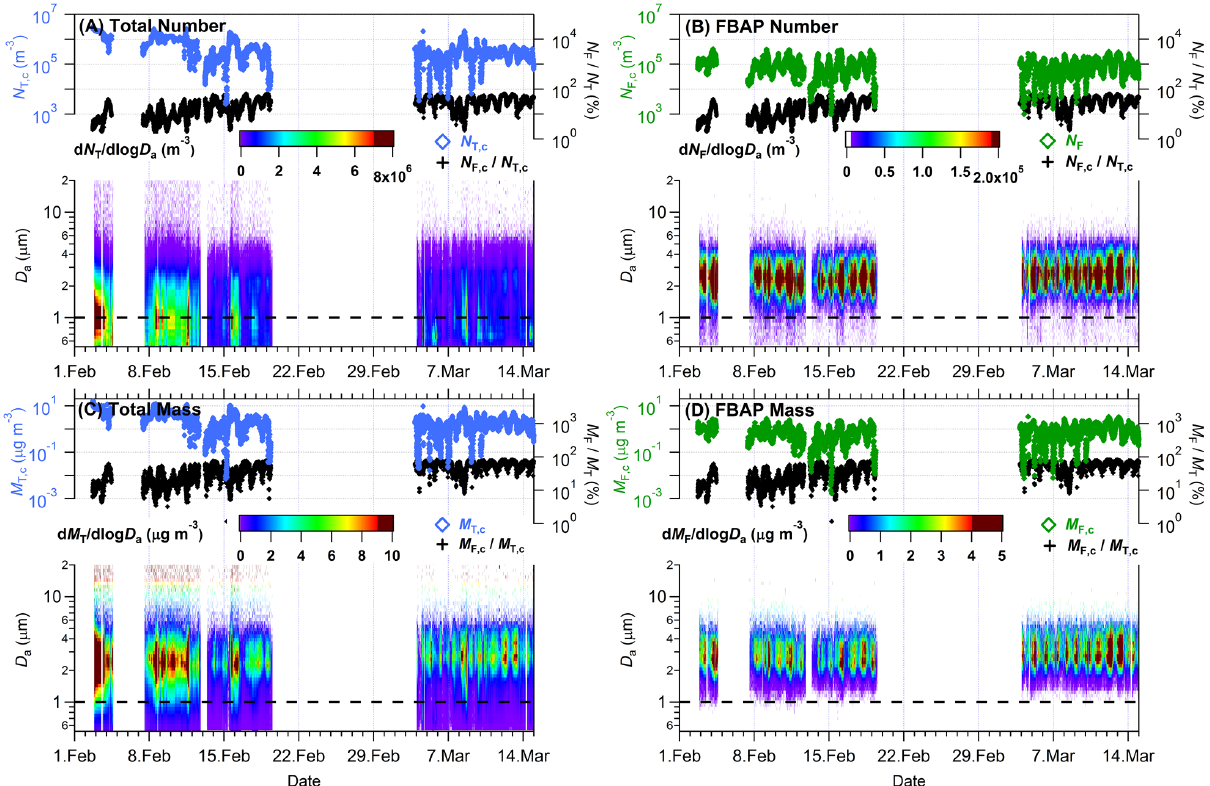
Fig. 1. Time series of particle concentrations. Each panel: integrated values (upper left), ratio of fluorescent to total (upper right), and size- resolved measurements. (A) total number ( N T , c ) , (B) FBAP number ( N F , c ) , (C) total mass ( M T , c ) , (D) FBAP mass ( M F , c ) . Dashed line at 1µm indicates lower bound of number integration; mass is